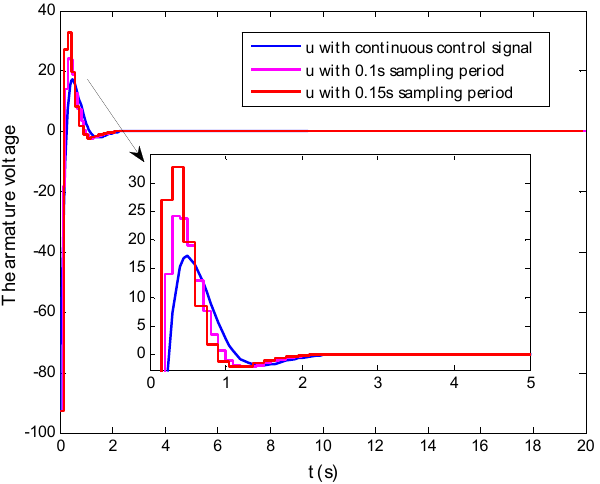
u with different sampling periods.